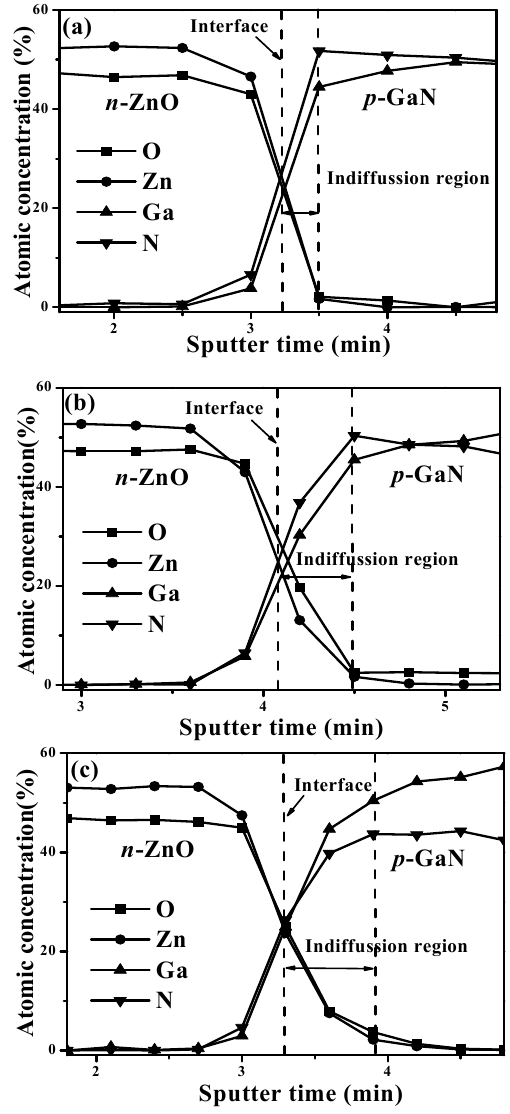
Figure 4. Auger electron spectroscopy (AES) depth profiles of n -ZnO/ p -GaN heterojunction structures annealed at ( a ) 450 °C; ( b ) 700 °C and ( c ) 800 °C, respectively, under vacuum atmosphere for 30 min.